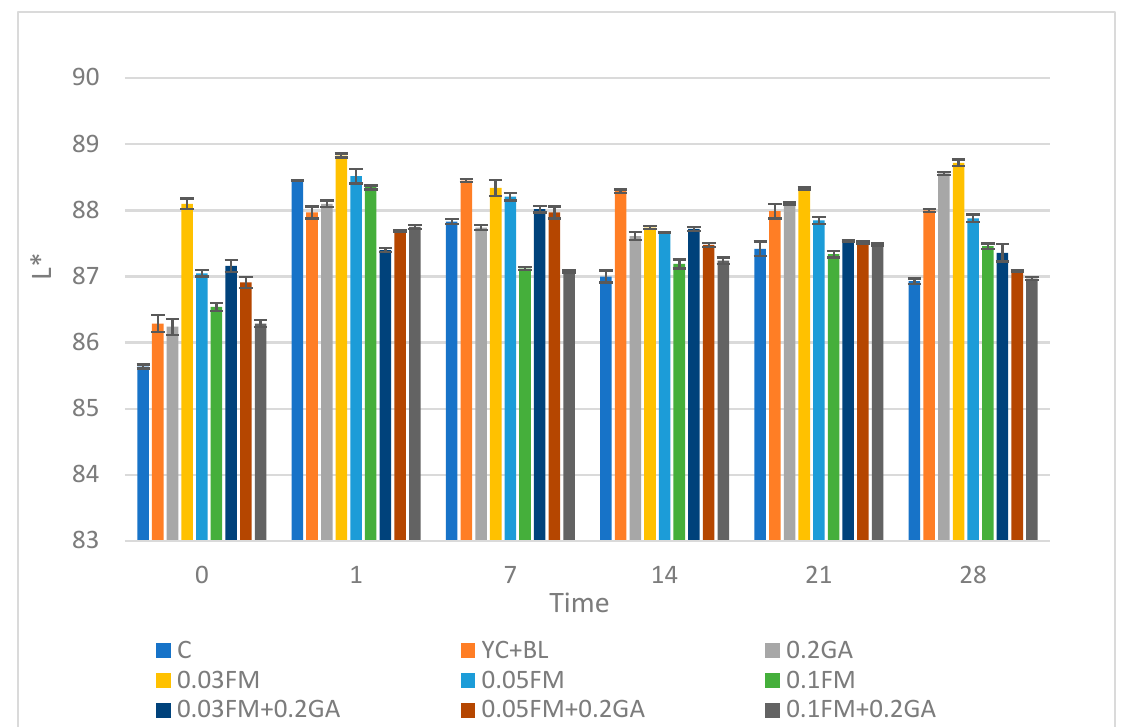
Figure 3. Effect of addition of FM, GA and yogurt culture and B. lactis at different concentrations on color L* value in kefir samples during storage time. Abbreviations: C, control; YC, yogurt culture; B.L, B. lactis ; GA, gum arabic; FM, flaxseed mucilage.